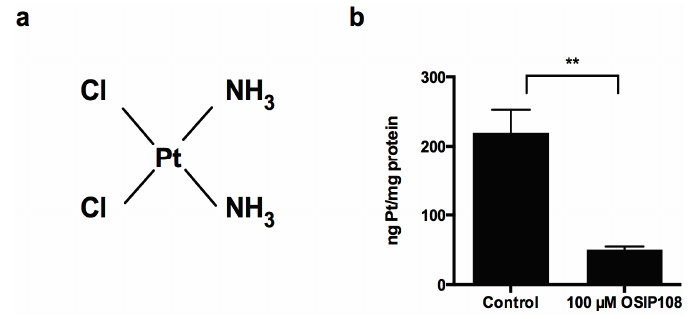
Figure 3. OSIP108 blocks uptake of Cp in HepG2 cells ( a ) Chemical structure of Cp; ( b ) HepG2 cells were exposed to Cp (10 µM) for 48 h in absence (control, 1% DMSO) or presence of OSIP108 (100 µM) and intracellular platinum (Pt) was measured by HR-CS AAS. Results are given at ng Pt per mg of protein in the cell lysates. Data is average from three independent experiments. ( ** p < 0.01; Student t